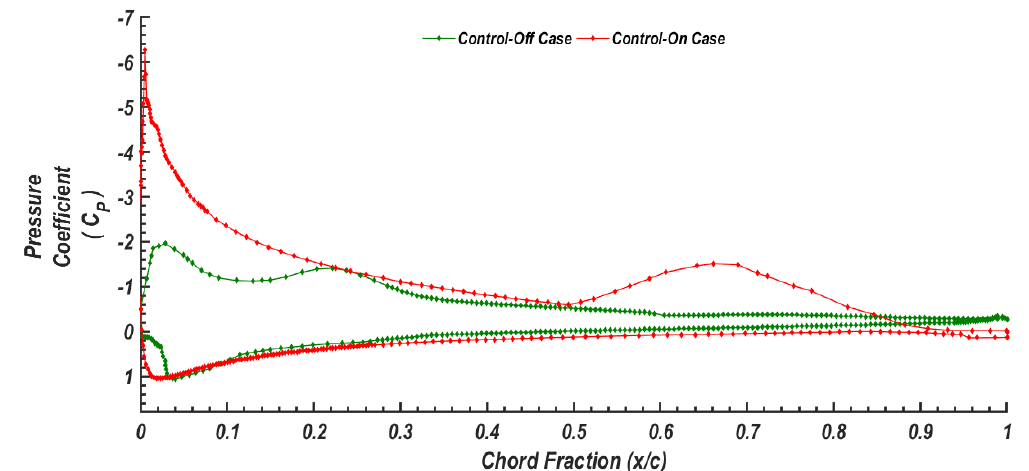
Figure 24. Comparison of chord-wise average pressure coefficient curves along the sides of the airfoil at AoA = 16° for the control-off case and control-on cases.